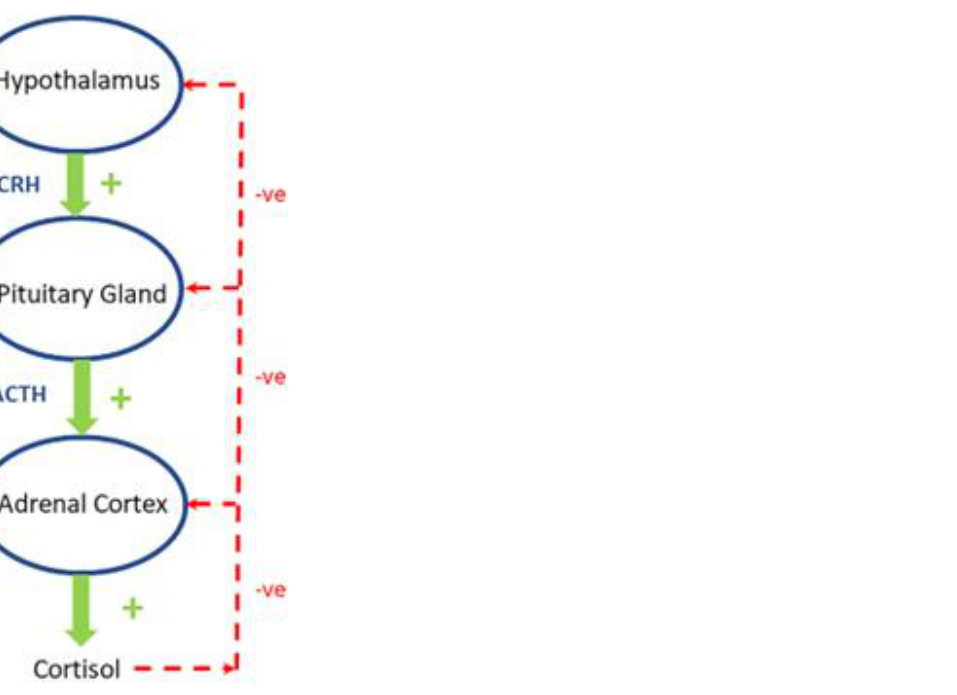
Figure 3. In healthy subjects, corticotropin-releasing hormone (CRH) stimulates the secretion of adrenocorticotropic hormone (ACTH) in the anterior lobe of the pituitary gland. ACTH in turn acts on the adrenal cortex which produces glucocorticoid hormones (mainly cortisol in humans) in response to stimulation by ACTH. Cortisol in turn acts back on the hypothalamus and the pituitary (to suppress CRH and ACTH) production in a negative feedback cycle. Stimulatory effects are shown in green and inhibitory effects are shown in red. See text for more details.